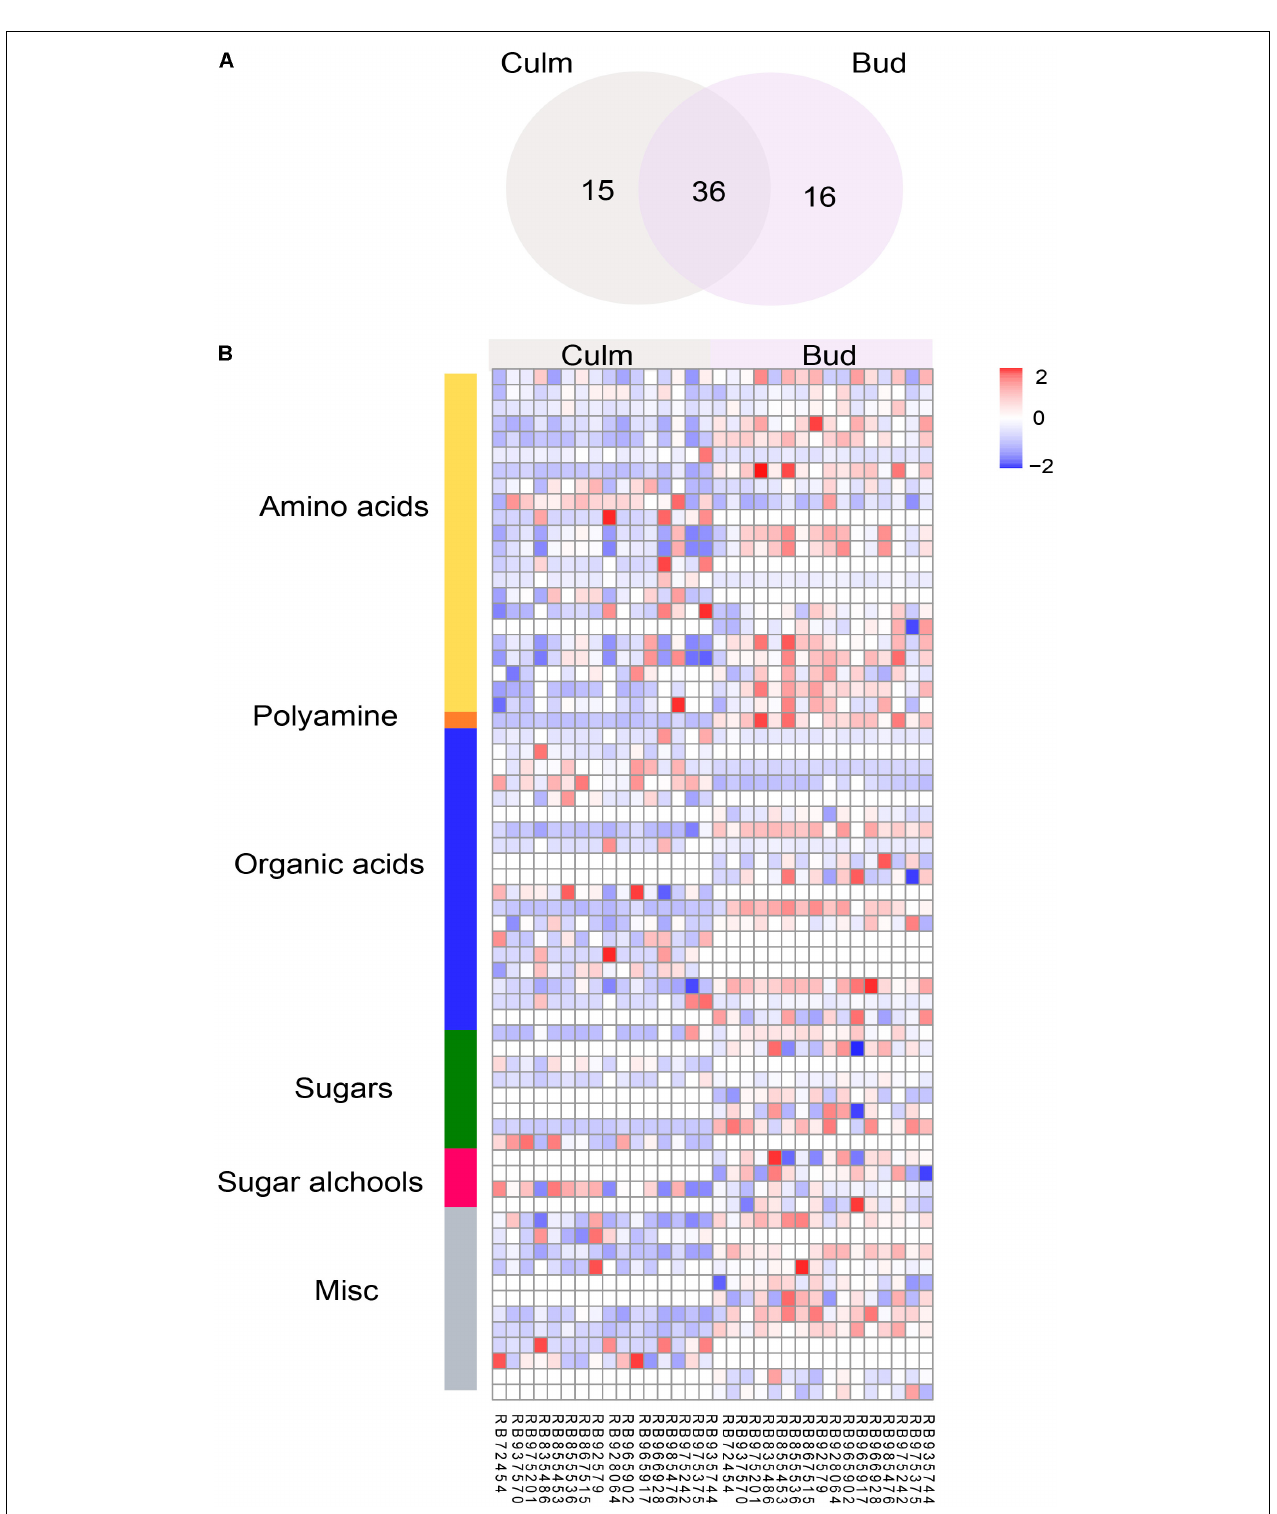
FIGURE 1 | Metabolic composition of buds and culms in different sugarcane commercial cultivars. (A) Number of metabolites identified in culm, bud, and common to both tissues; (B) Differential abundance of metabolites in culms and buds according to their compound class. Each column represents the genotype mean, and each row represents a metabolite. Variations in the relative abundance of metabolites are displayed in blue (low) to red (high).